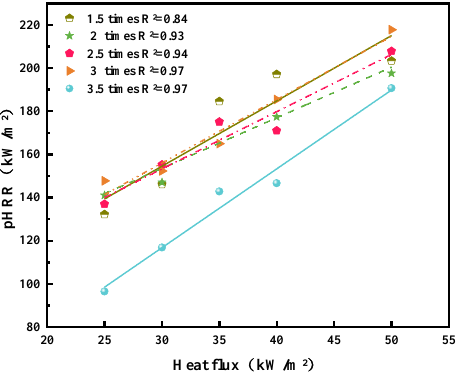
Figure 8. pHRR for the wires at various external heat fluxes.